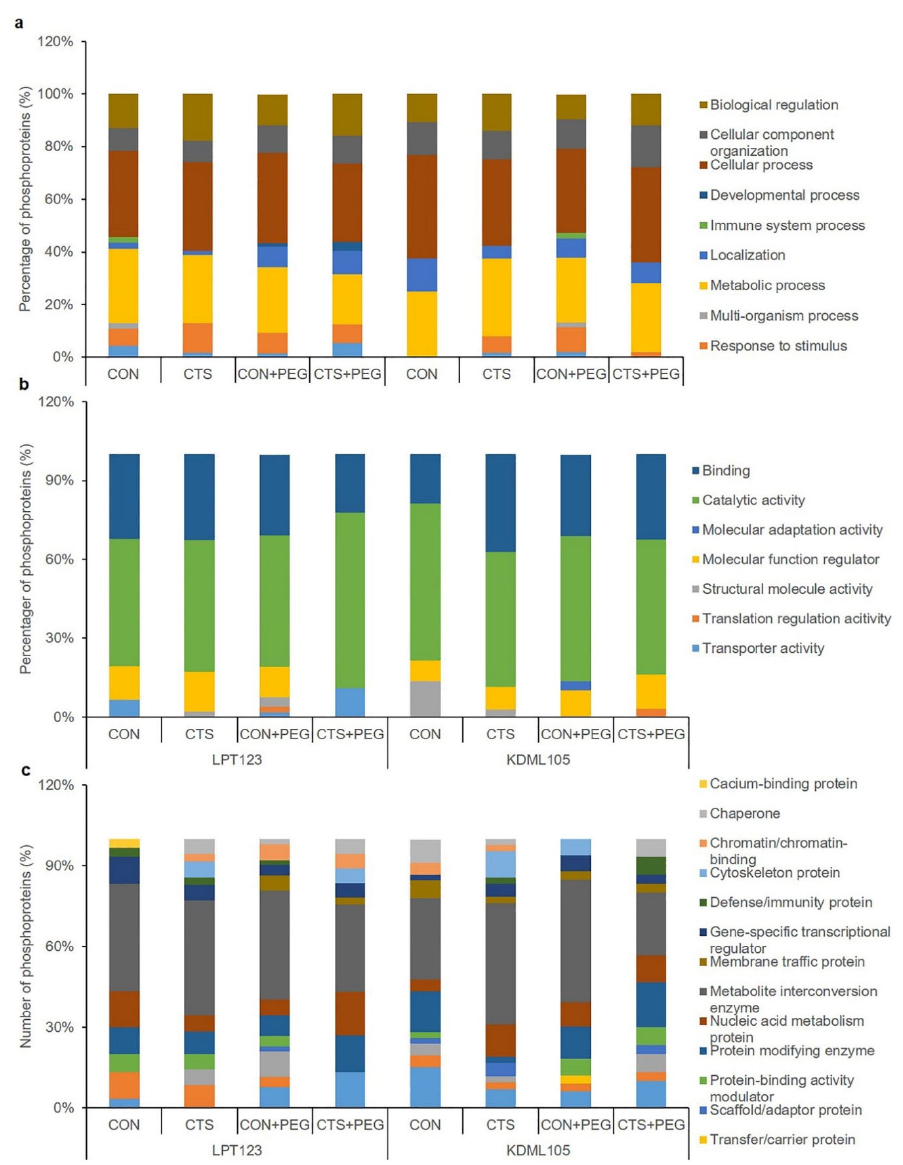
Figure 3. Gene ontology (GO) analysis provided three categories, including biological processes ( a ) molecular function; ( b ) and cellular components ( c ) of DEPs of LPT123 and KDML105 rice cultivars.